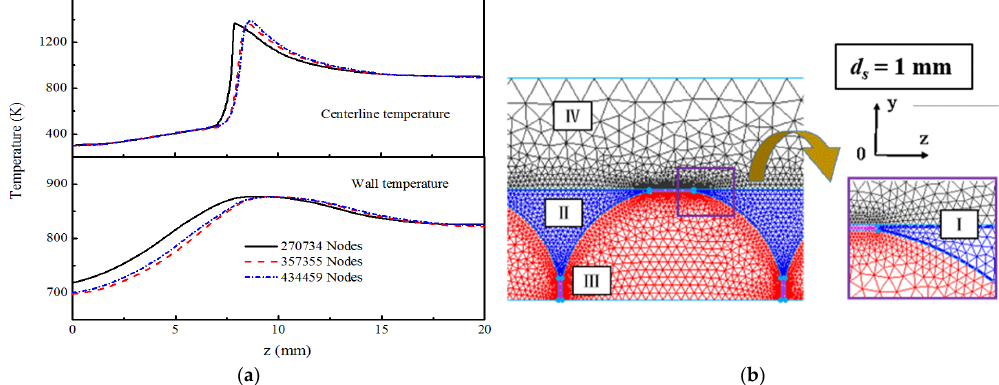
Figure 2. Mesh generation. ( a ) Result of grid independence test obtained by the PSM, U 0 = 2 m/s, Φ = 0.65, d s = 1 mm, ε = 0.48, k s = 5 W/m-K, and k w = 20 W/m-K; ( b ) local representation of the mesh with 357,355 nodes ( d s = 1 mm).